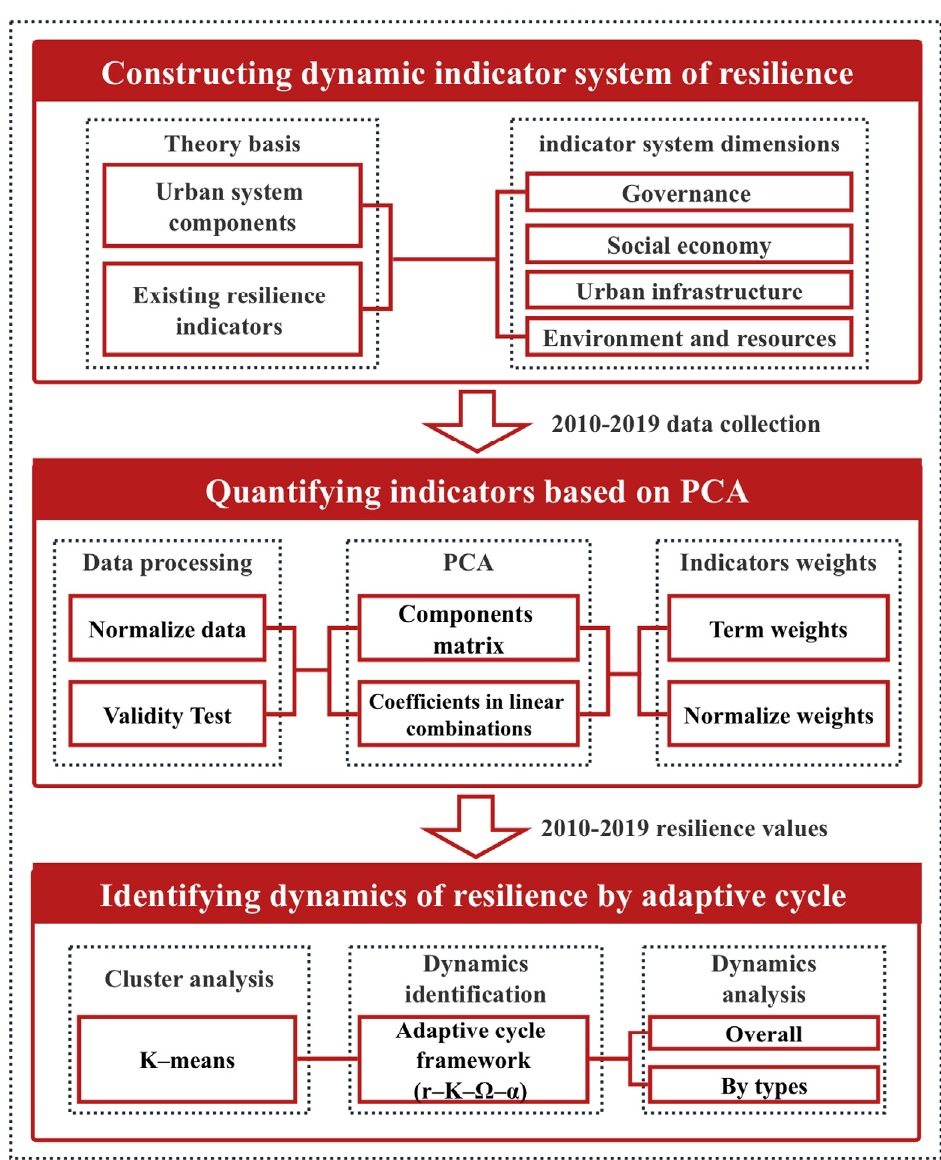
Figure 2. Conceptual framework.